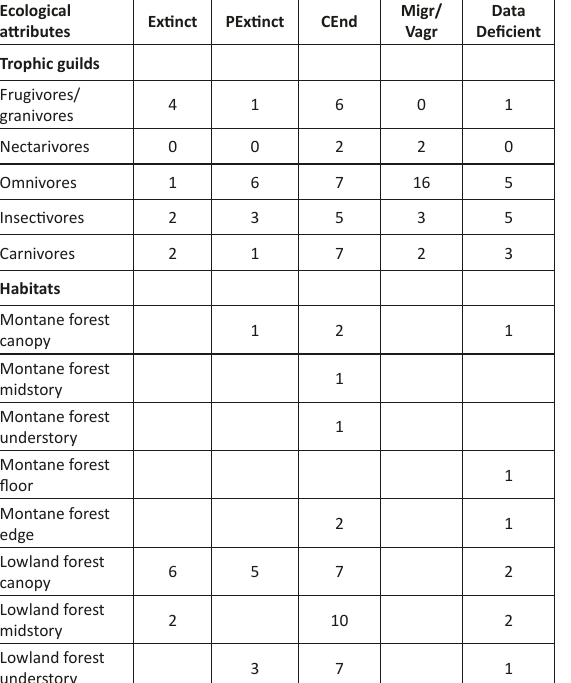
with two of these species ( Tigrisoma fasciatum